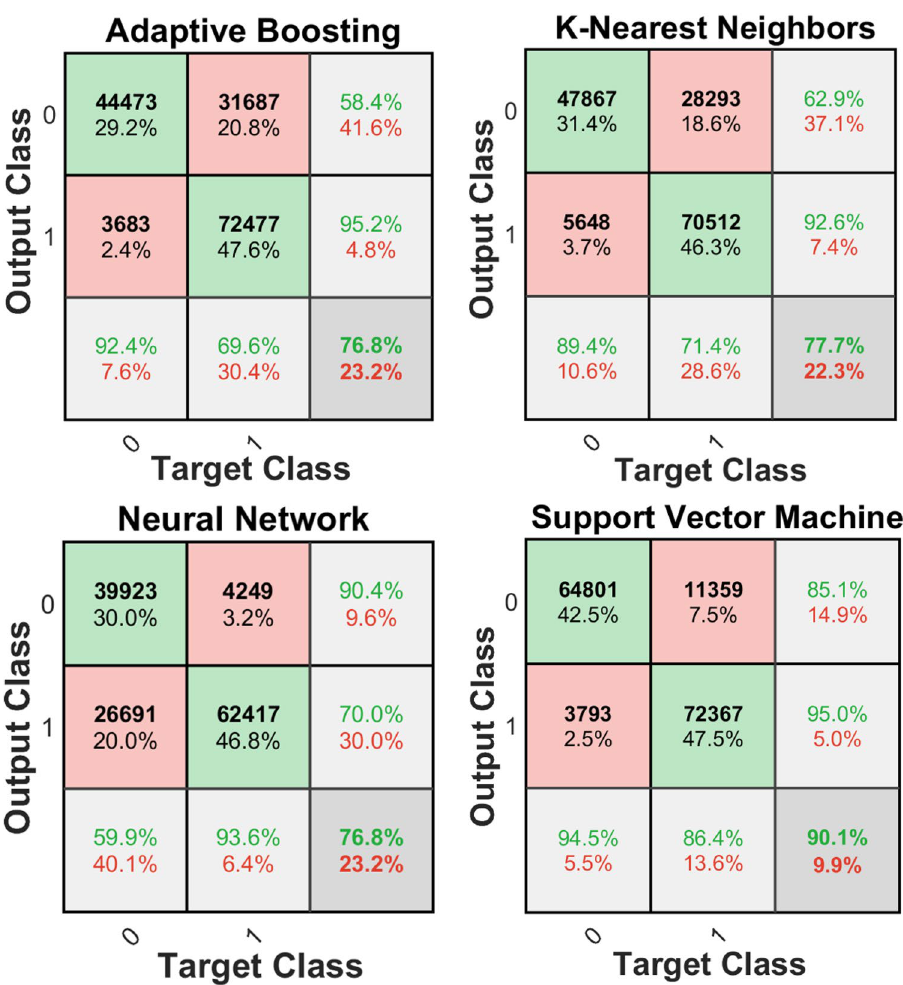
Figure 4. Confusion matrices corresponding to the different algorithms used for the 2-class problem constructed with combined test sets (n = 6 rats). This data was tested on Model 1 only. The last row and column of each confusion matrix show the recall and precision per class (class0: efferent, class1: afferent),